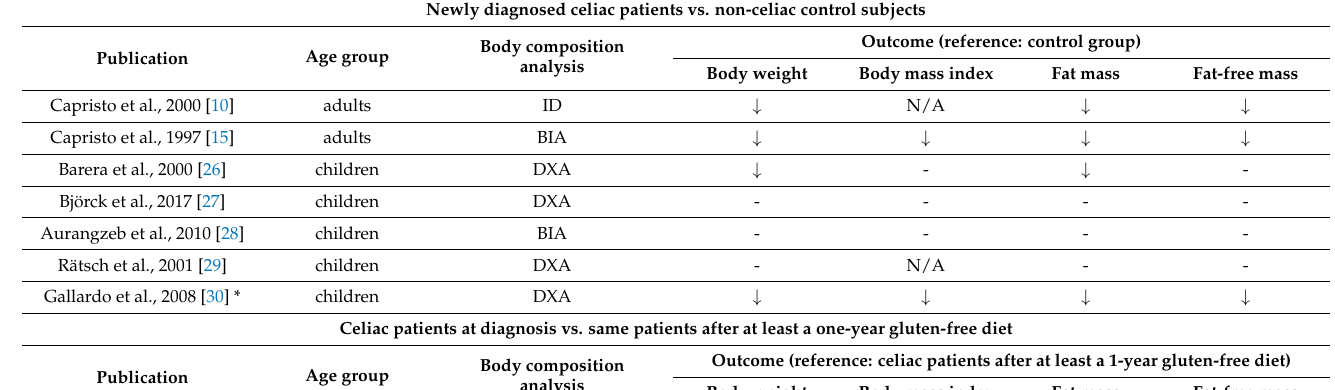
Table 2. Results of systematic